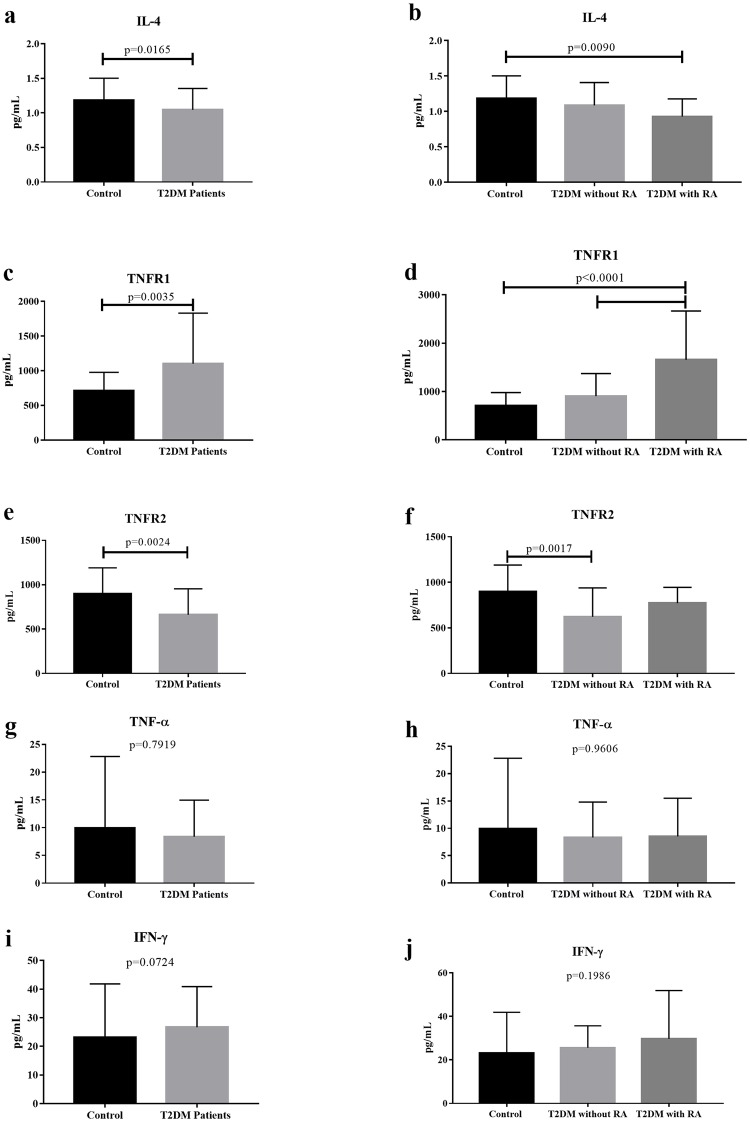
Serum cytokine concentrations in the T2DM group without and with RA and control group.(a) Serum IL-4 level in T2DM patients and controls and (b) T2DM patients without and with RA vs. controls. (c) Serum TNFR1 level in T2DM patients and controls and (d) T2DM patients without and with RA vs. controls. (e) Serum TNFR2 level in T2DM patients and controls and (f) T2DM patients without and with RA vs. controls. (g) Serum TNF-α in T2DM patients and controls and (h) T2DM patients without and with RA vs. controls. (i) Serum INF-γ level in T2DM patients and controls and (j) T2DM patients without and with RA vs. controls. The results were expressed as mean ± standard deviation. RA, renal alteration.